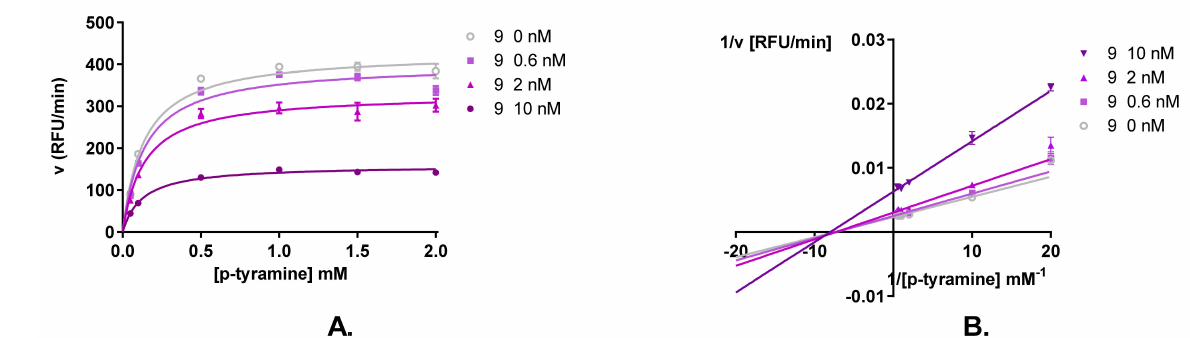
Figure 3. Michaelis–Menten curves ( A ) and Lineweaver–Burk plot ( B ) for 9 . Compound showed noncompetitive inhibition with equal affinity to the free enzyme and enzyme-substrate